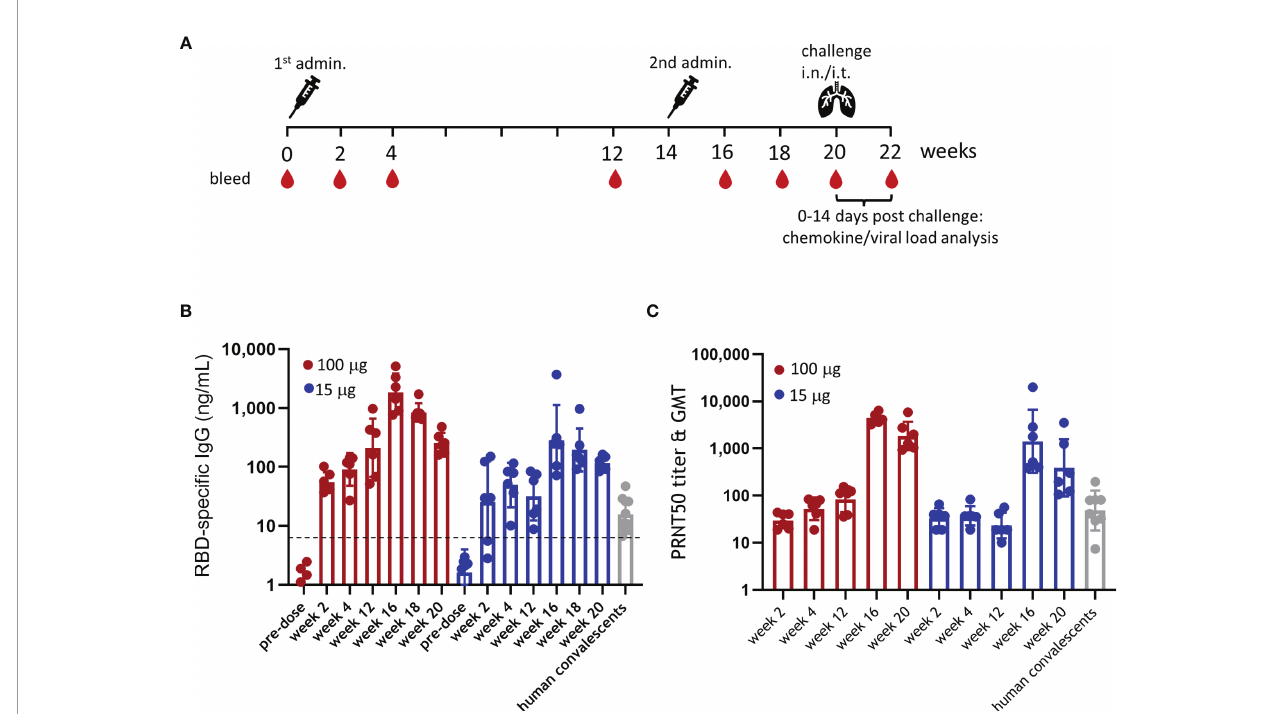
FIGURE 1 | Experimental design and immunogenicity of ABNCoV2. (A) Schematic study design with non-human primates (NHP) ( N = 6 per group) vaccinated intramuscularly with 100 or 15 m g ABNCoV2 in weeks 0 and 14 and challenged with severe acute respiratory syndrome coronavirus 2 (SARS-CoV-2) in week 20. Four (4) additional non-vaccinated NHP were added as controls. At regular intervals as indicated, animals were bled. (B) RBD-speci fi c IgG was measured by ELISA, and (C) SARS-CoV-2 neutralizing antibodies were assessed by PRNT. For comparison, 10 human plasma samples positive for SARS-CoV-2 antibodies (human convalescents, gray symbols) were analyzed as well. Filled circles represent individual values and columns depict the geometric mean (ELISA, B ) or geometric mean titers (PRNT, C ) of the group +/geometric standard deviation. The horizontal dotted line in (B) represents the mean + 2 times the standard deviation of 50 untreated naive NHP to indicate background